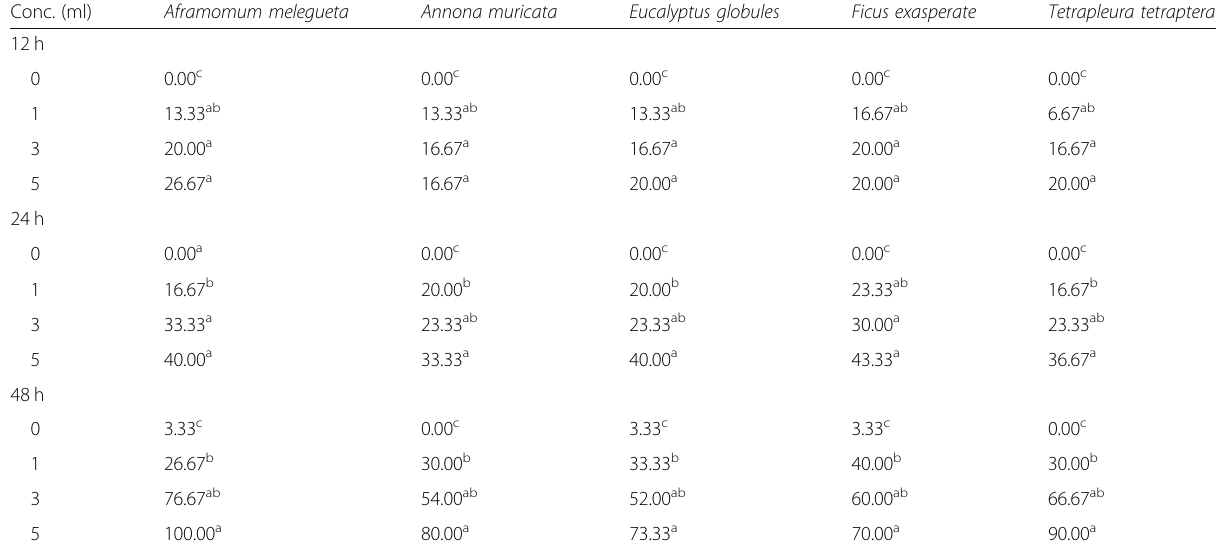
Table 2 Percentage mortality of C. maculatus on cowpea seeds treated with different concentrations of essential oil from botanicals at different time intervals Conc. (ml)